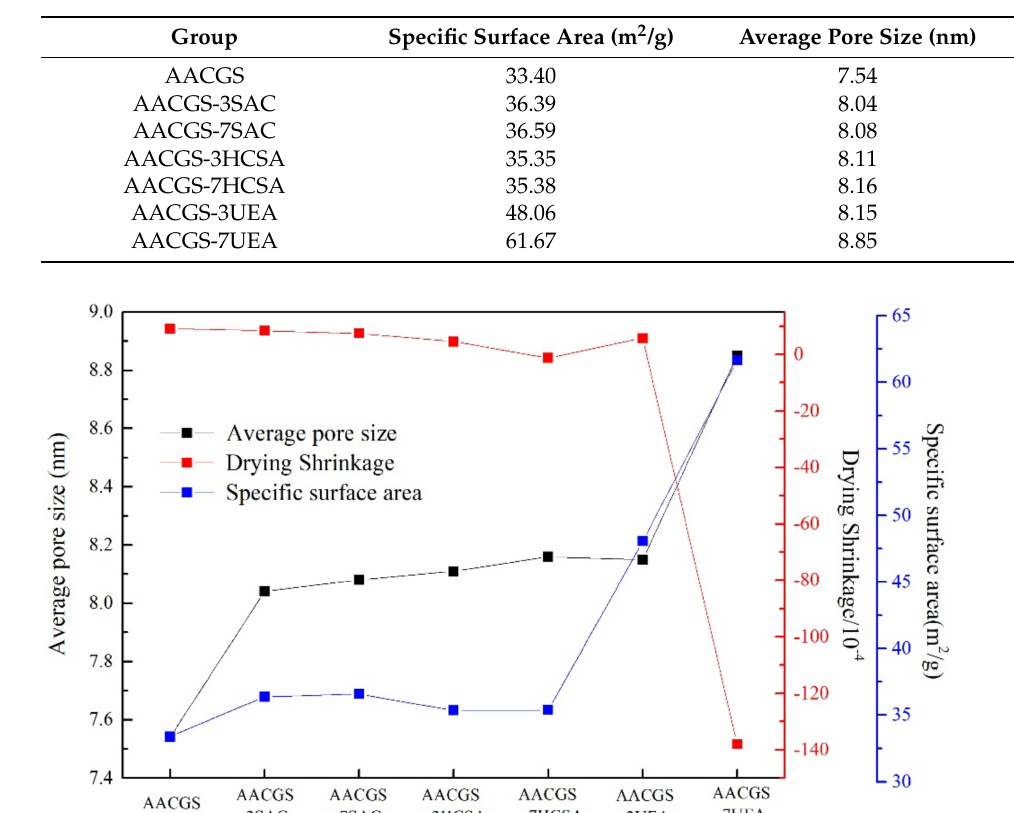
Table 4. Average pore size of AACGS mortar (%).